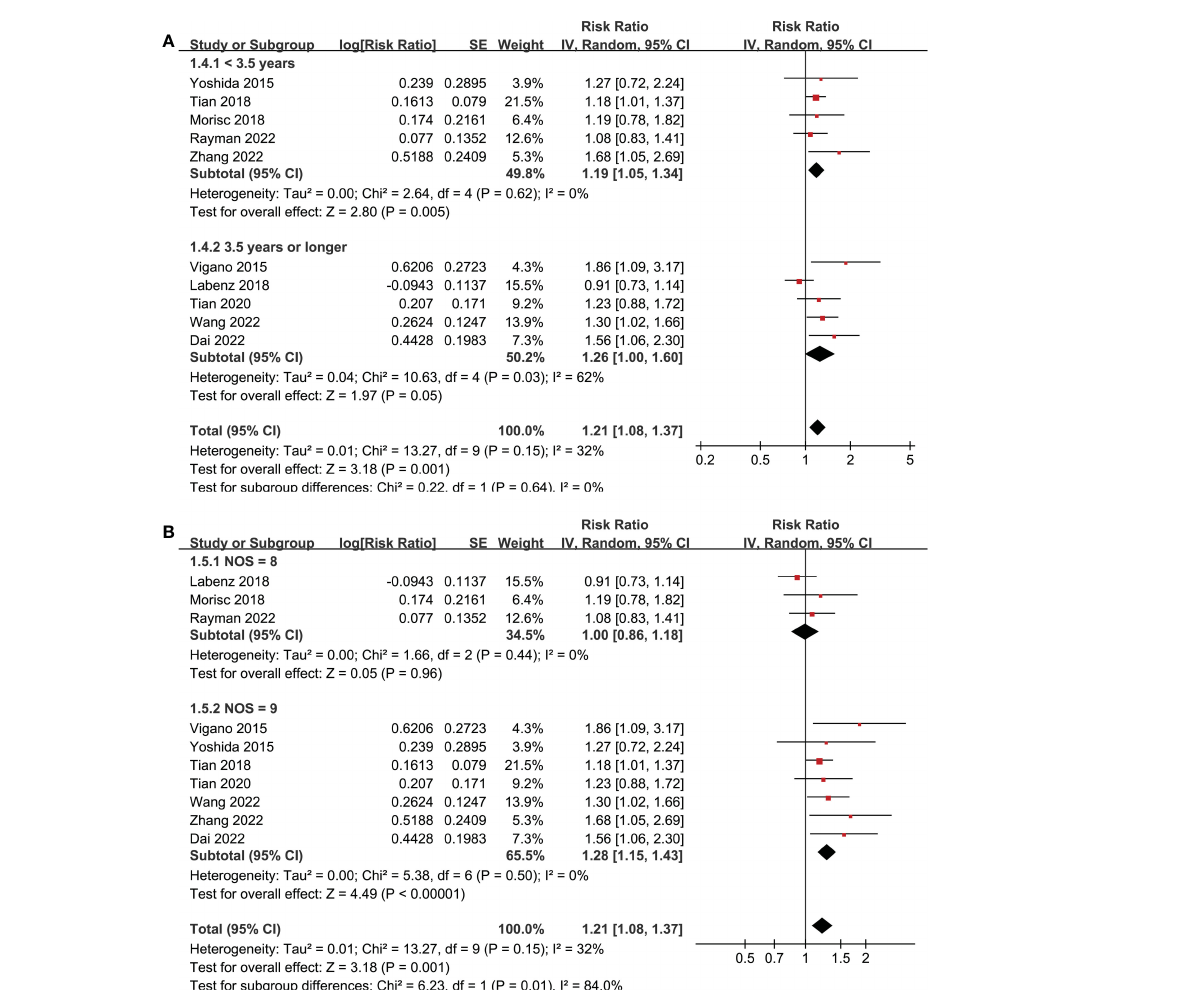
FIGURE 3 Forest plots for the subgroup-analyses regarding the association between MetS and OS in patients with HCC. (A) subgroup analysis according to the follow-up durations; and (B) subgroup analysis according to the study quality